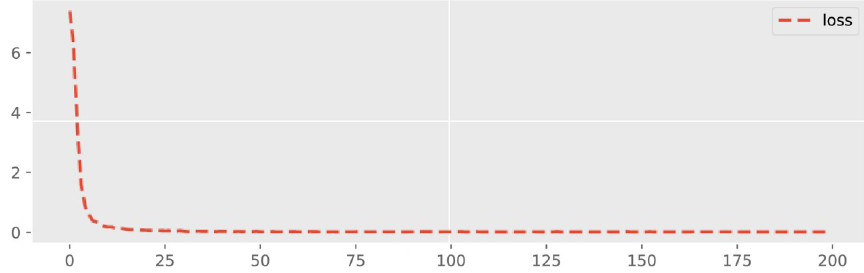
Fig 9. Validation loss across 200 epochs for Offshore Windfarm 1 based on adopted fine-tuned forecasting settings.